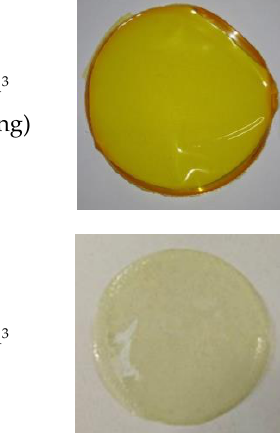
Figure 1. Structure, properties and membrane sample of PIM-EA(H 2 )-TB and Matrimid. Density from Ref. [37] and [42],